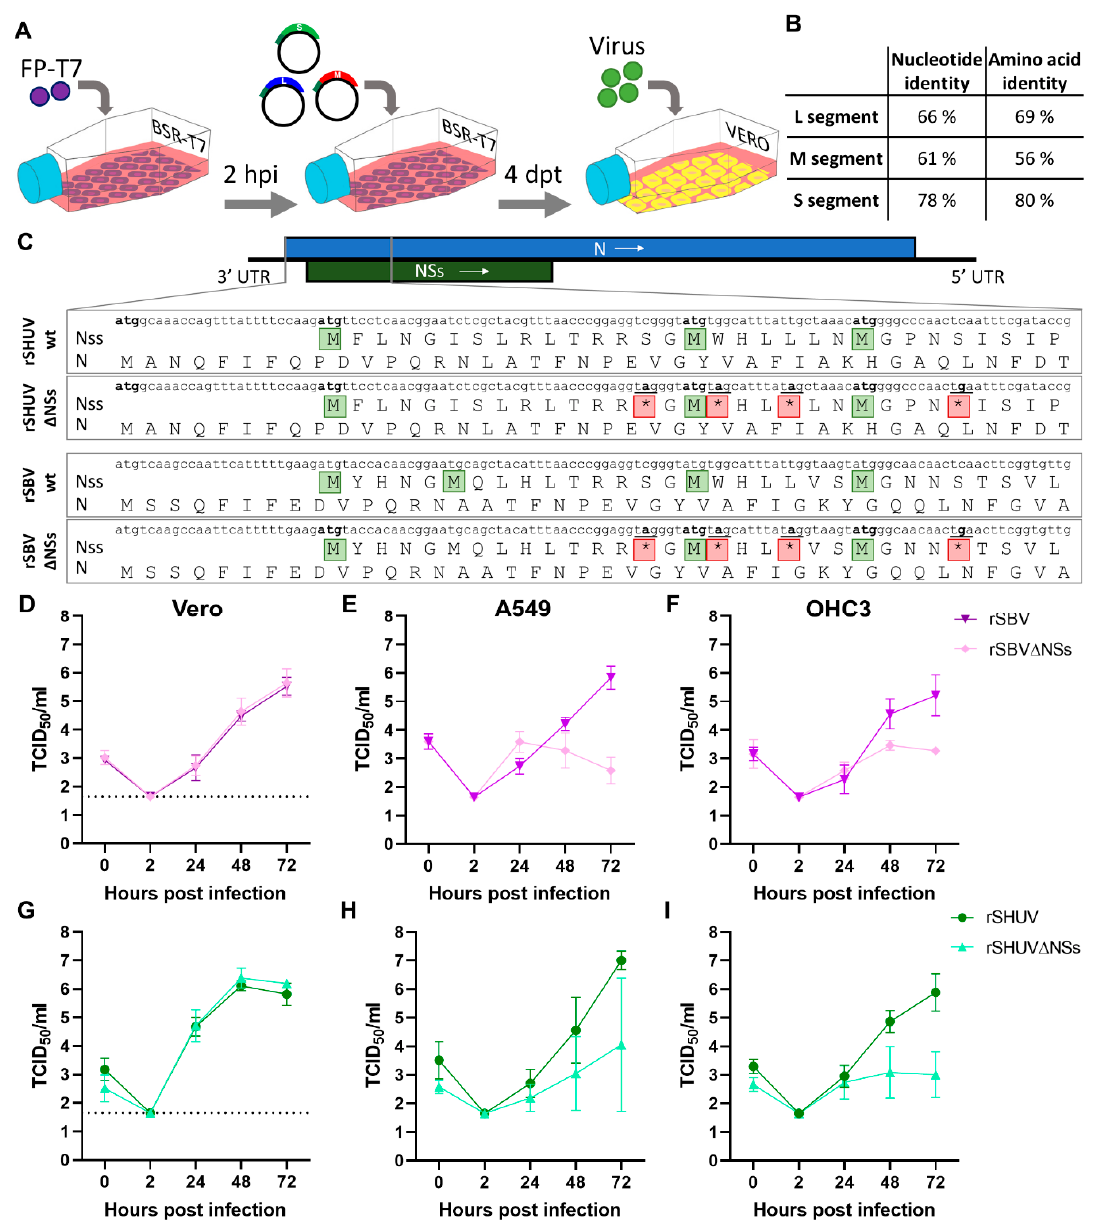
Figure 1. Rescue and growth characterization of recombinant Shuni virus (SHUV). ( A ) A schematic presentation of the reverse genetics system. Briefly, BSR-T7 cells were incubated with FP-T7. Two hours later, the medium was replaced, and the cells were transfected with pUC57 plasmids encoding each of the three genome segments. Supernatants containing recombinant virus were harvested at 4 days post transfection and transferred to Vero cells. The virus was harvested from the Vero cells at 4 dpi. ( B ) Nucleotide and amino acid identity between wild-type rSBV and rSHUV. ( C ) Partial sequences of the S-segments of rSHUV, rSHUV ∆ NSs, rSBV, and rSBV ∆ NSs. The start codons are marked by green boxes. The four introduced stop codons are indicated by red boxes. The replication of rSBV (purple) and rSBV ∆ NSs (pink) in Vero cells ( D ), A549 ( E ), and OHC3 cells ( F ). The replication of rSHUV (light green) and rSHUV ∆ NSs (dark green) in Vero ( G ), A549 ( H ), and OHC3 cells ( I ). The cells were infected at a multiplicity of infection (MOI) of 0.01, and the samples were collected at 0, 2, 24, 48, and 72 hpi. At 2 hpi, the inocula were removed, the cells were washed, and fresh medium was added.